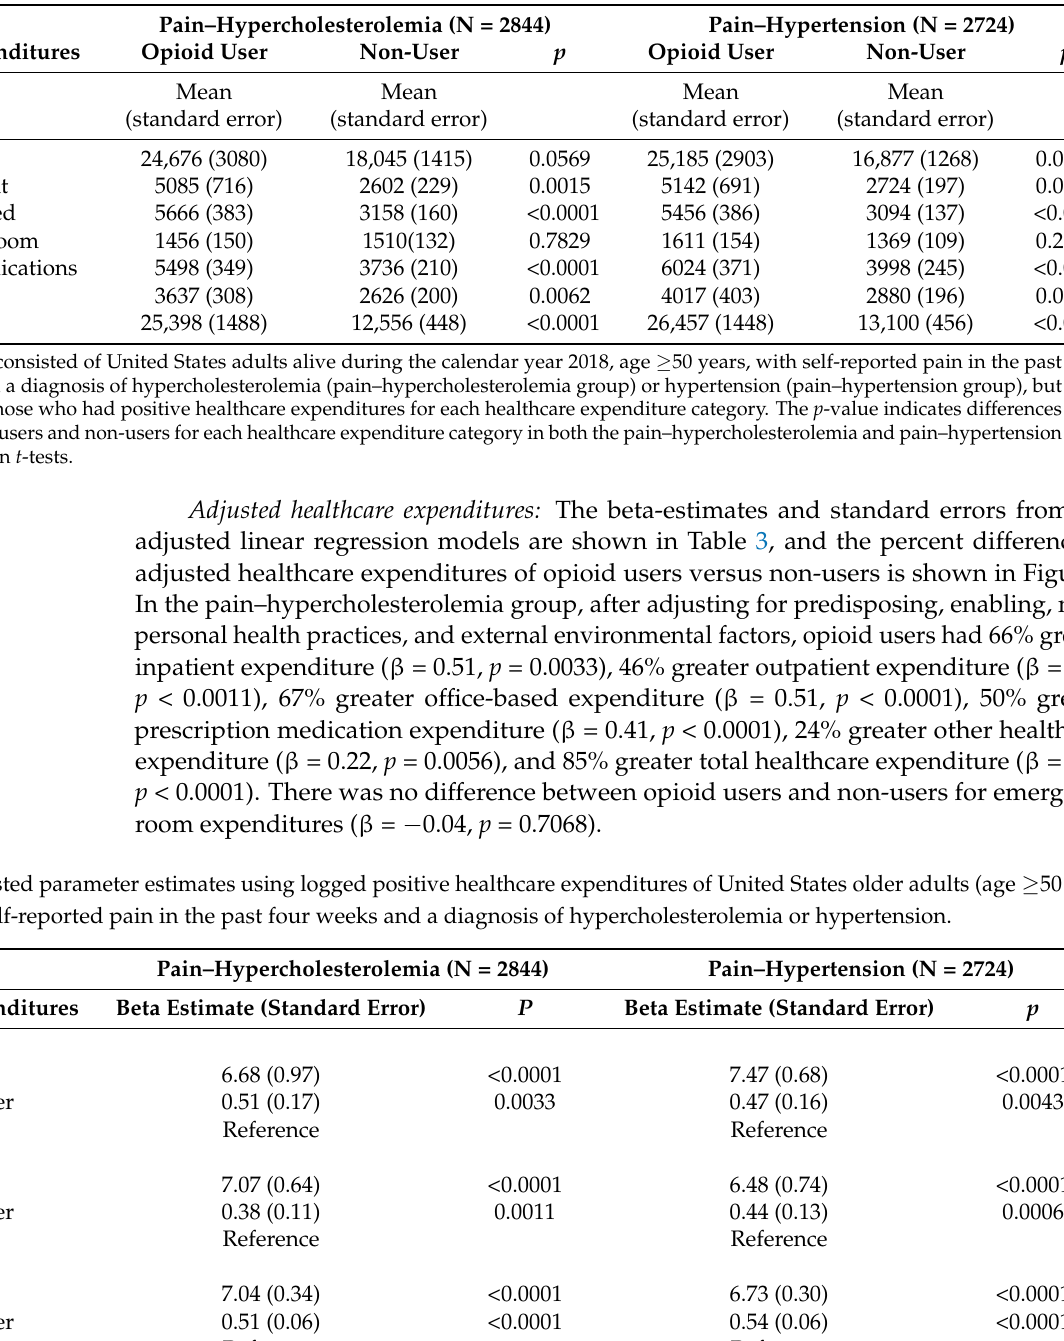
Table 2. Descriptive healthcare expenditures of United States older adults (age ≥ 50 years) with self-reported pain in the past four weeks and a diagnosis of hypercholesterolemia or hypertension.